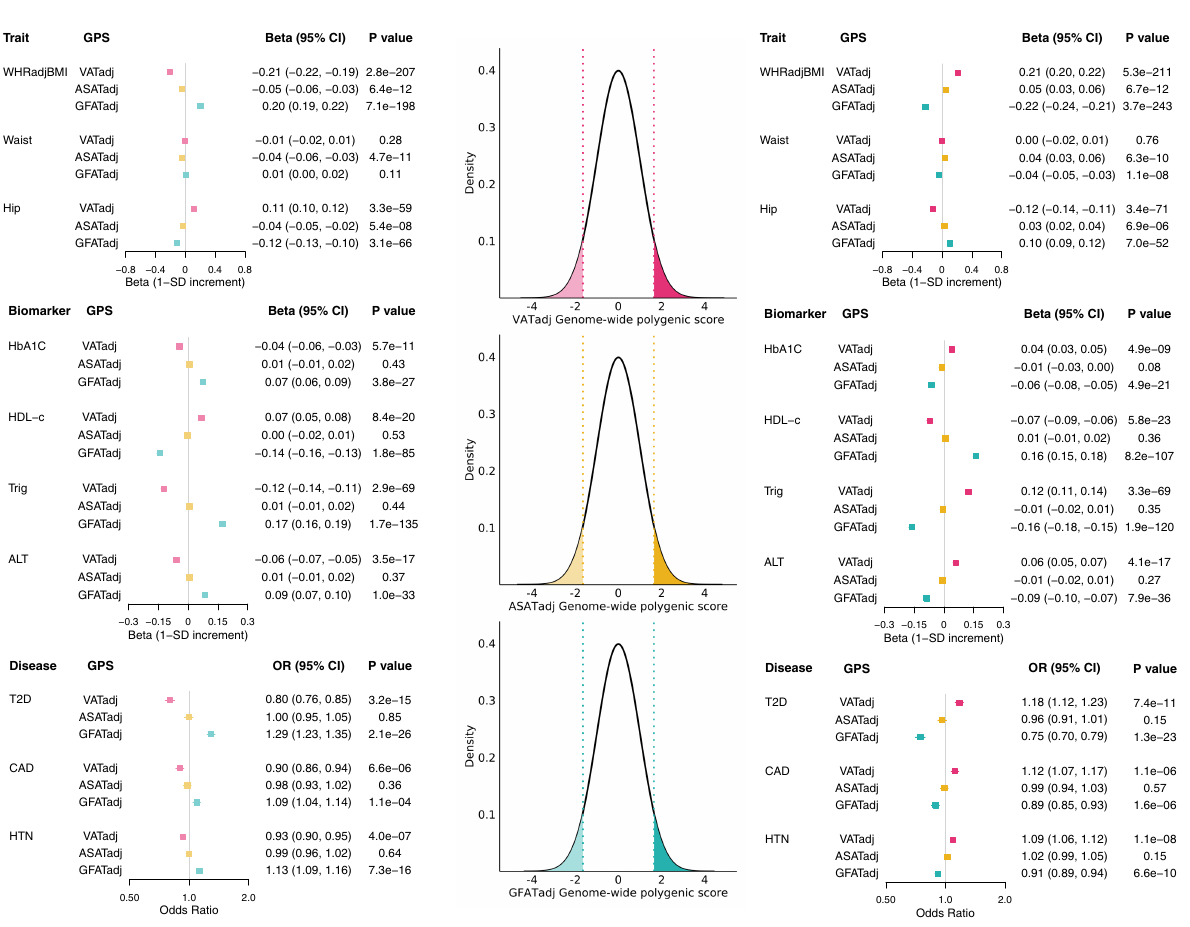
than the 5th percentile (14.3% vs. 4.7%; OR = 3.36; 95% CI: 2.32 – 4.77). These fi ndings suggest that polygenic inheritance We next tested the relationship between VATadj, ASATadj, and GFATadj polygenic scores and biomarkers of metabolic health (hemoglobin A1C, HDL cholesterol, serum triglycerides, and alanine aminotransferase (ALT)) and disease outcomes (type 2 diabetes, hypertension, and coronary artery disease) (Fig. 7 and Supplementary Data 20). Within an independent dataset of 447,486 individuals of the UK Biobank who were genotyped, but not imaged, individuals in the top 5% of the GFATadj polygenic score had higher HDL- cholesterol (beta: 0.16 SD; 95% CI: 0.15 – 0.18; p = 8.2 × 10 − 107 ), lower serum triglycerides (beta: − 0.16 SD; 95% CI: − 0.18 – − 0.15; p = 1.9 × 10 − 120 ), lower serum ALT (beta: − 0.09; 95% CI: